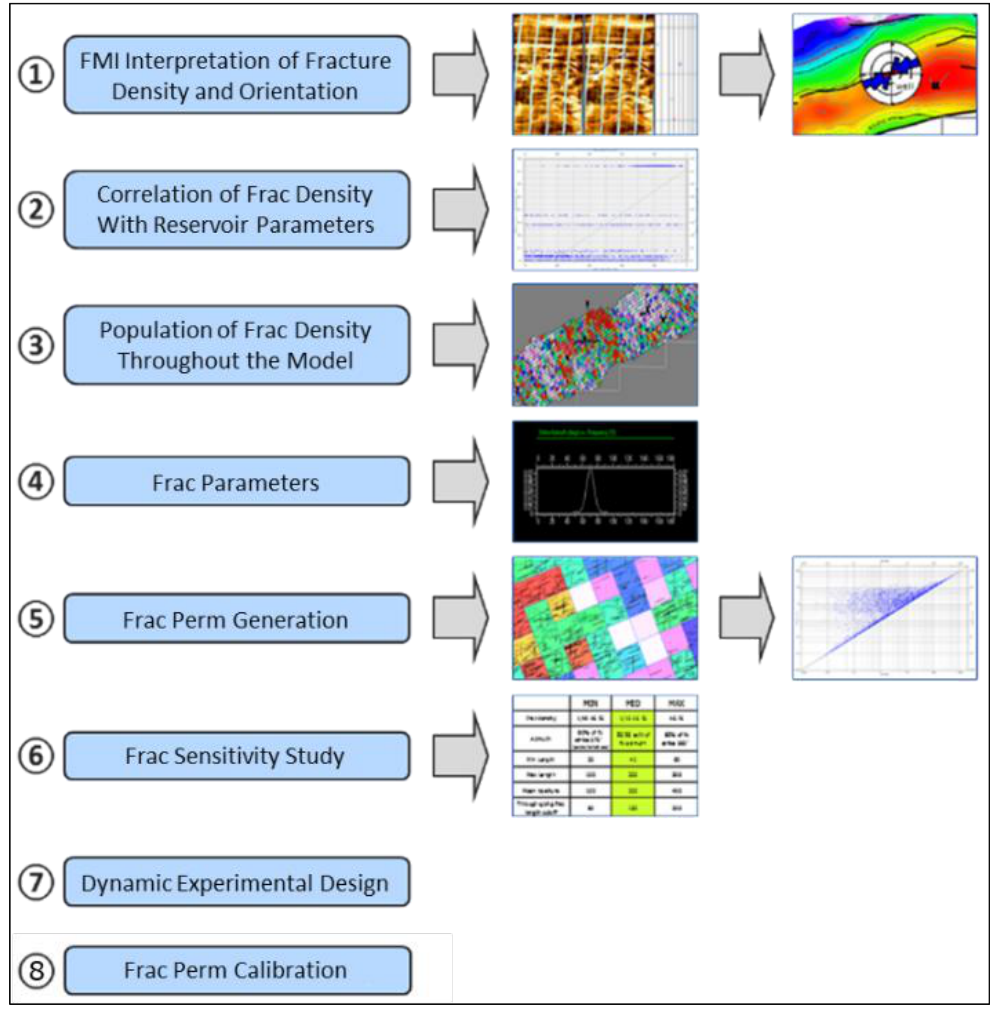
Figure 9—Fracture Modelling Workflow (courtesy Eric A. Flodin and Jerome